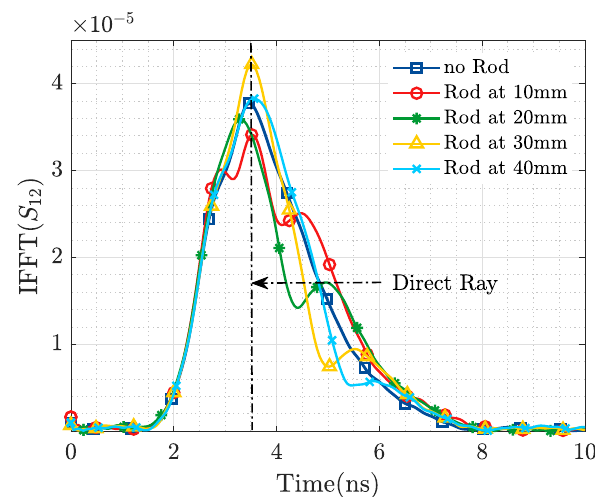
Figure 9. Metallic Rod Detection. Experimental measurement